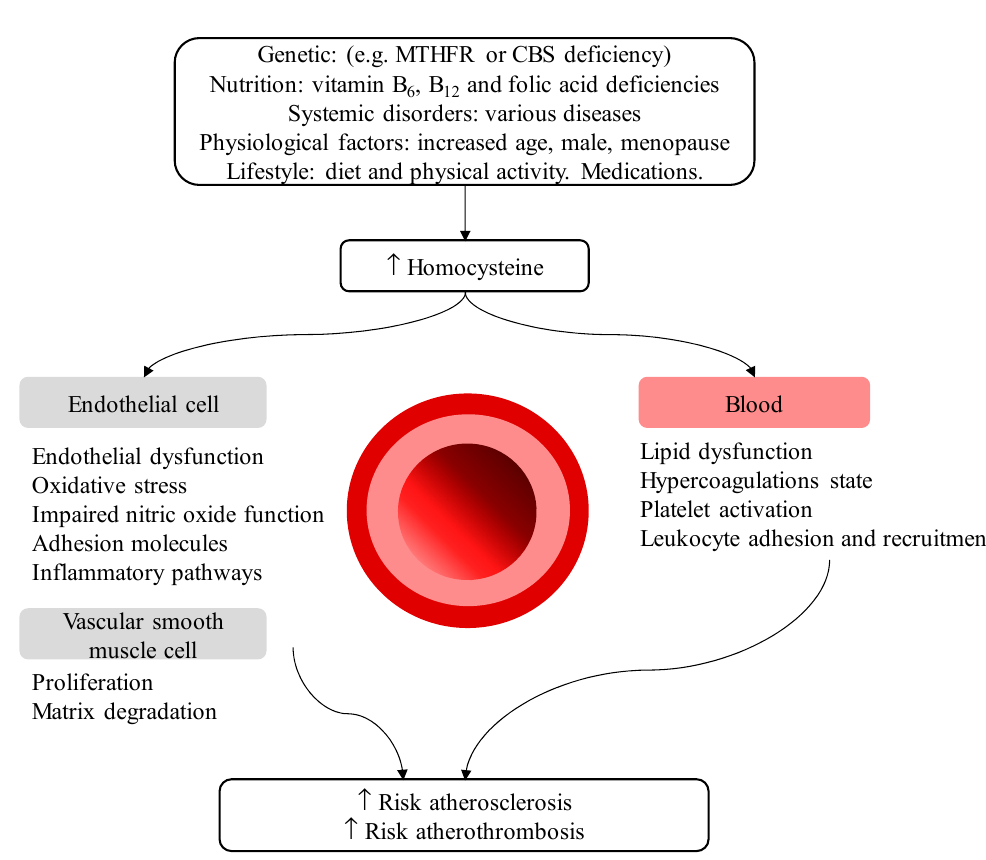
Figure 2. Risk factors and mechanisms for high homocysteine in cardiovascular disease. MTHFR: methylenetetrahydrofolate reductase, CBS: cystathionine beta-synthase.